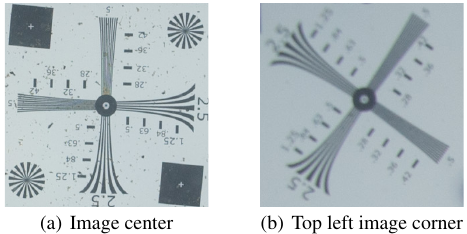
Figure 8. Exemplary targets in image center (a) and in the top left image corner (b). Sharpness reduction can be observed towards the edges, probably overlaying refraction